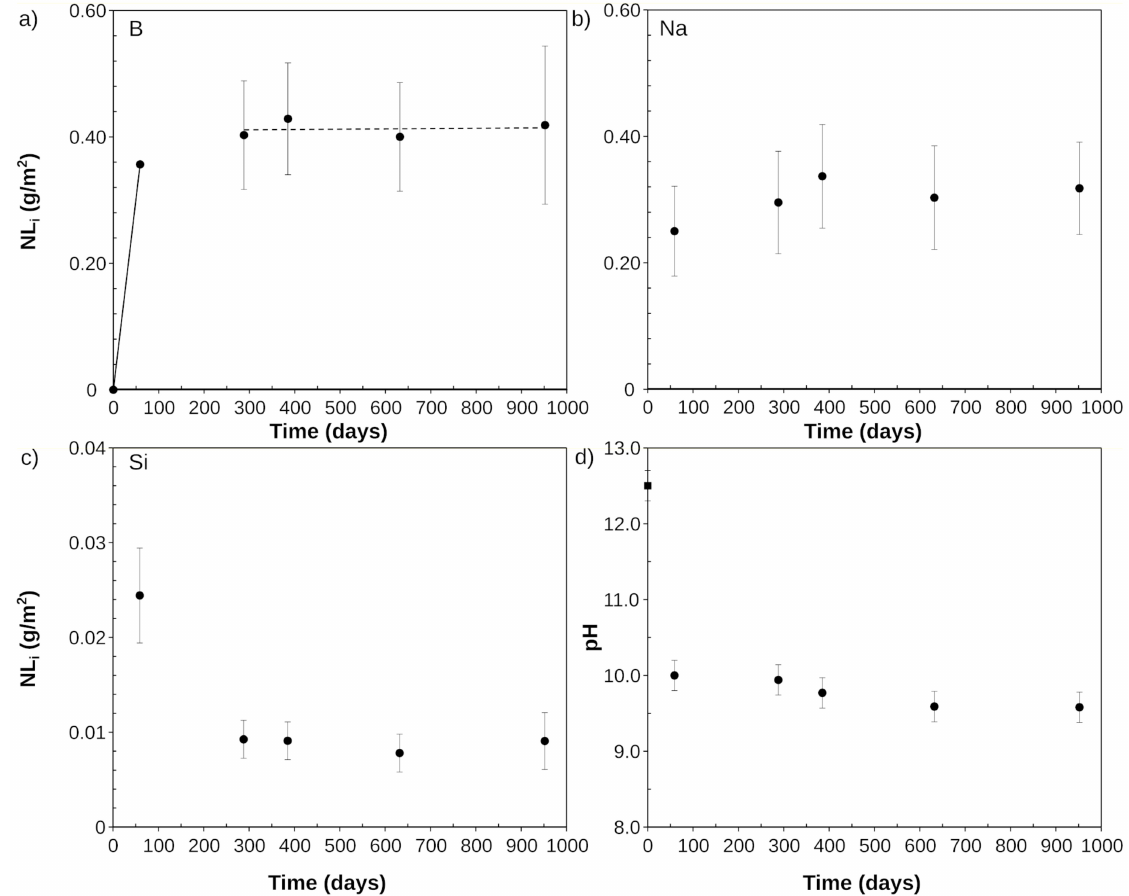
Figure 2. Normalized mass loss NL i of ISG components up to 952 days in YCWCa at 70 ◦ C: ( a ) NL B (showing the linear regressions from which the dissolution rates were derived), ( b ) NL Na and ( c ) NL Si ; ( d ) evolution of the pH (70 ◦ C) with